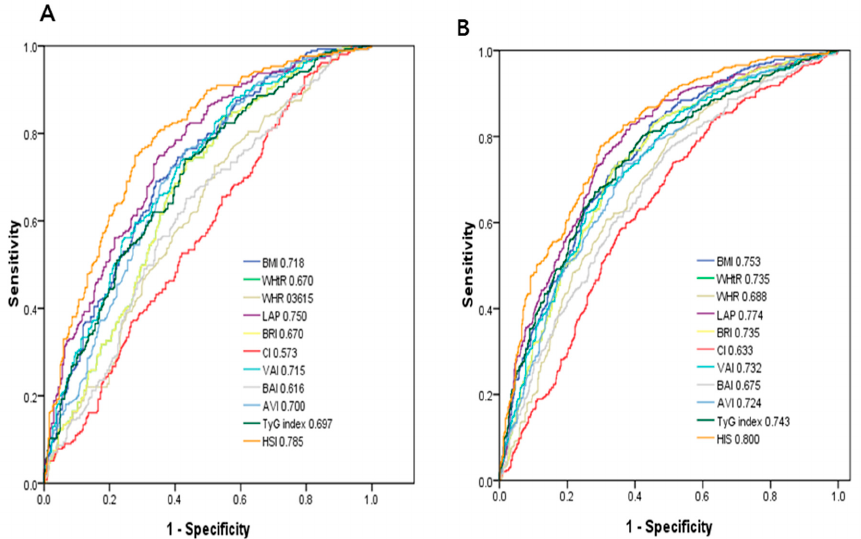
Figure 1. Comparison of the predictive value of 11 obesity-related parameters for diagnosis of NAFLD among ( A ) males and ( B ) females. 3.4. Association between MetS and the Obesity-Related Indices with the Severity of NAFLD Table 4 shows comorbidity and the values of obesity-related indices according to the severity of NAFLD in the study participants. The values of all obesity-related indices in- creased with the severity of NAFLD (from absent to severe, ANOVA p < 0.001). There were significant trends of stepwise increases in all obesity-related indices. Table 4. Comorbidity and the values of obesity-related indices according to the severity of NAFLD in study participants. Absent ( n = 1143)